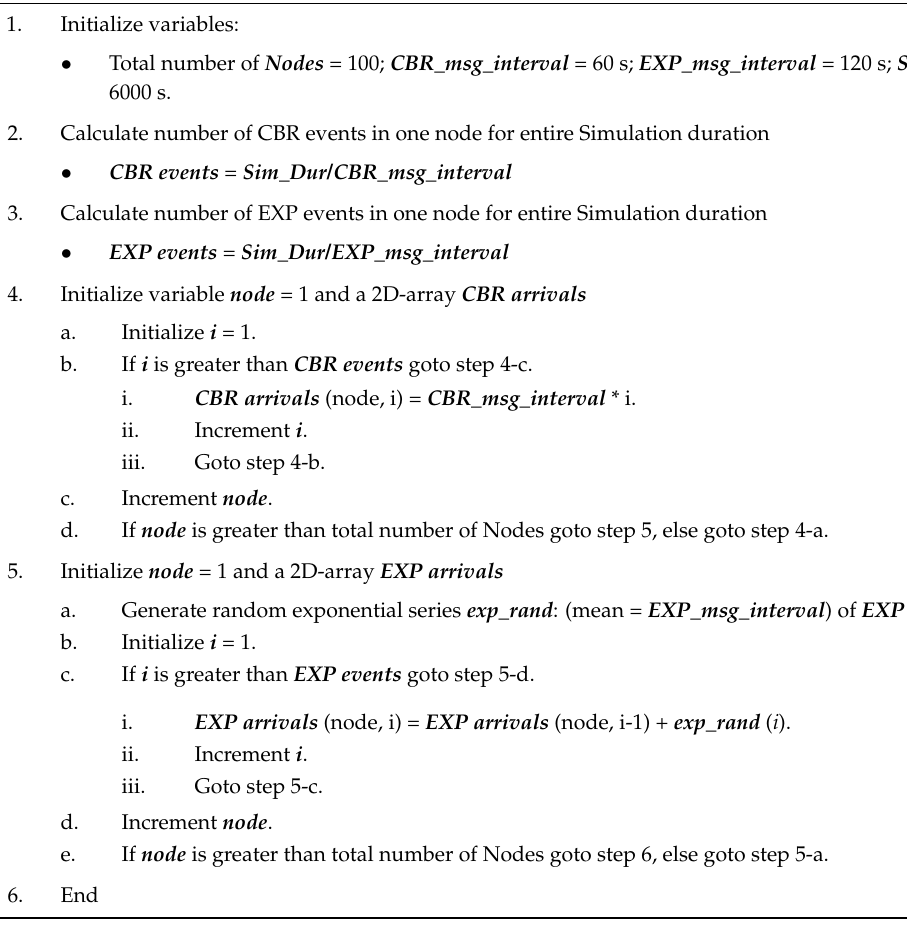
Algorithm 1. Generating Regular and Emergency Traffic